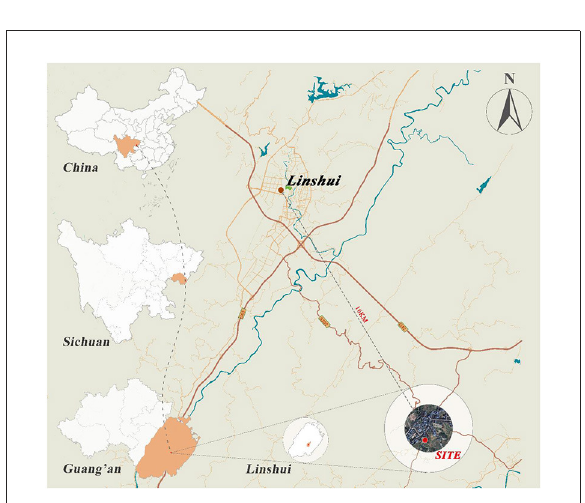
FIGURE2 The location of Linshui. Elaborated by the authors.